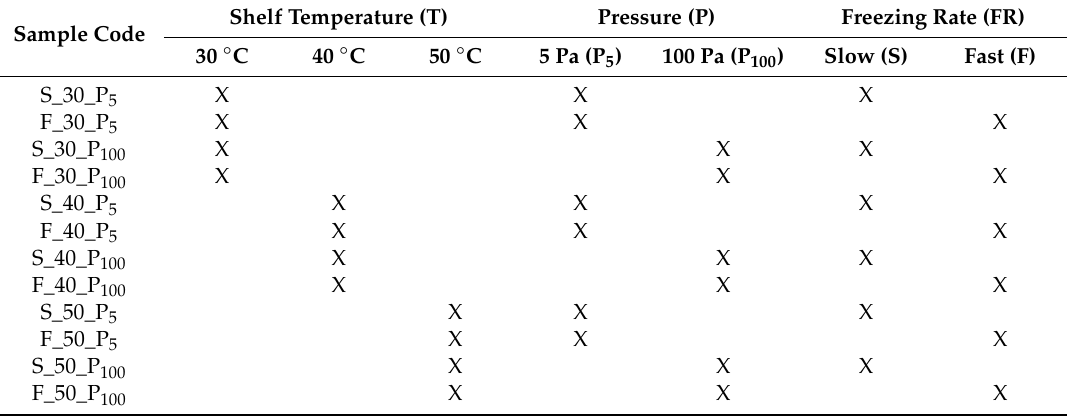
Table 1. Sample and conditions code according the 12 di ff erent freeze-drying conditions